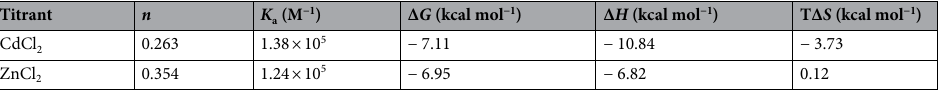
Table 6. Thermodynamic parameters for Cd 2+ or Zn 2+ titration into the AADAAC-F4 solution.